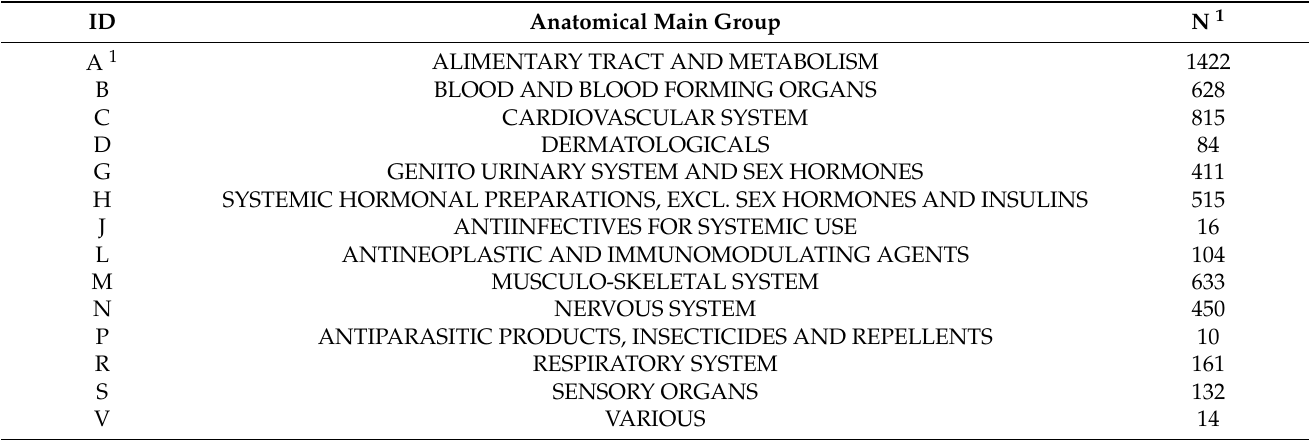
Table 2. Number of self-reported medication by ATC anatomical main group, based on responses of 6000 QBB participants, whereof 3086 reported to take at least one kind of